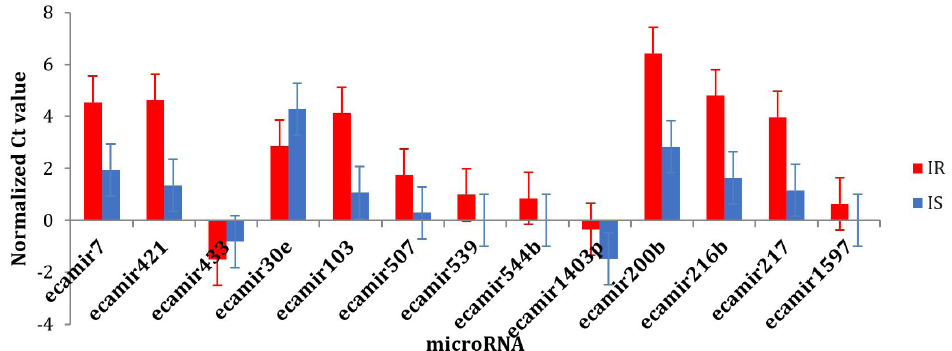
Figure 3. Delta Ct means and SE of significantly different miRNAs between groups: insulin sensitive (IS, n=10) and insulin resistant (IR, n=2) horses.